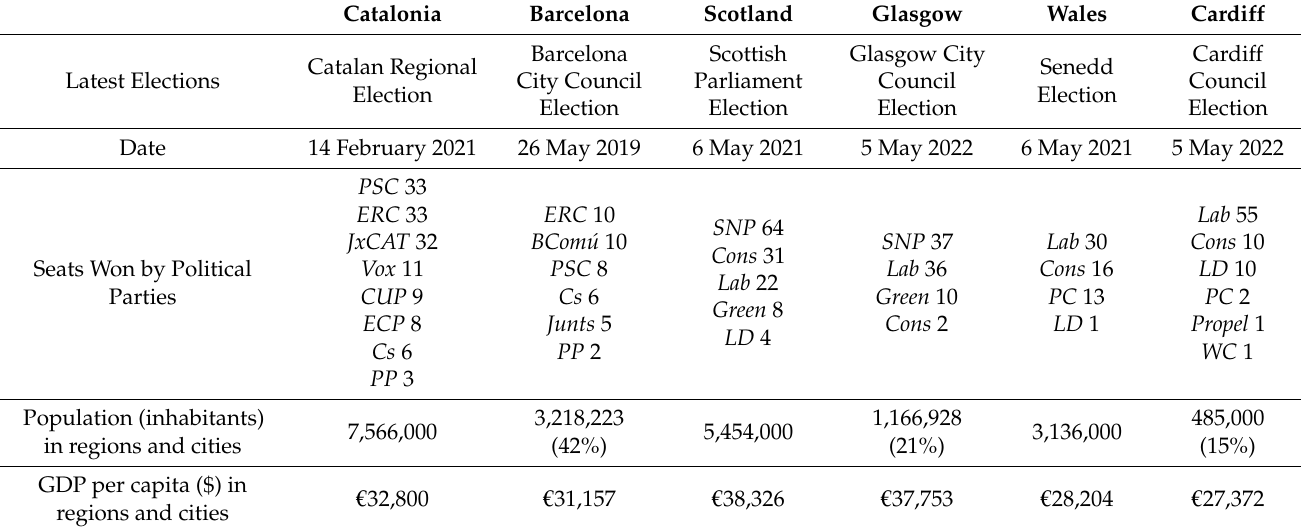
Table 1. Framing Case Study Methodology: Elections’ Results, Population, and GDP in the Three Case Studies (Regions-Cities): Catalonia-Barcelona, Scotland-Glasgow, and